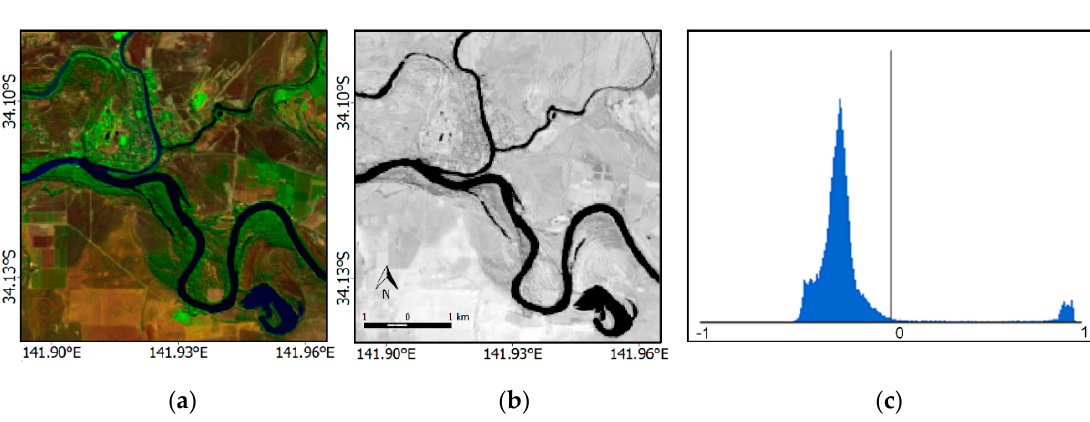
Figure 7. False-color composite image (SWIR1, NIR and green) ( a ); MNDWI index values ( b ); and its histogram ( c ).